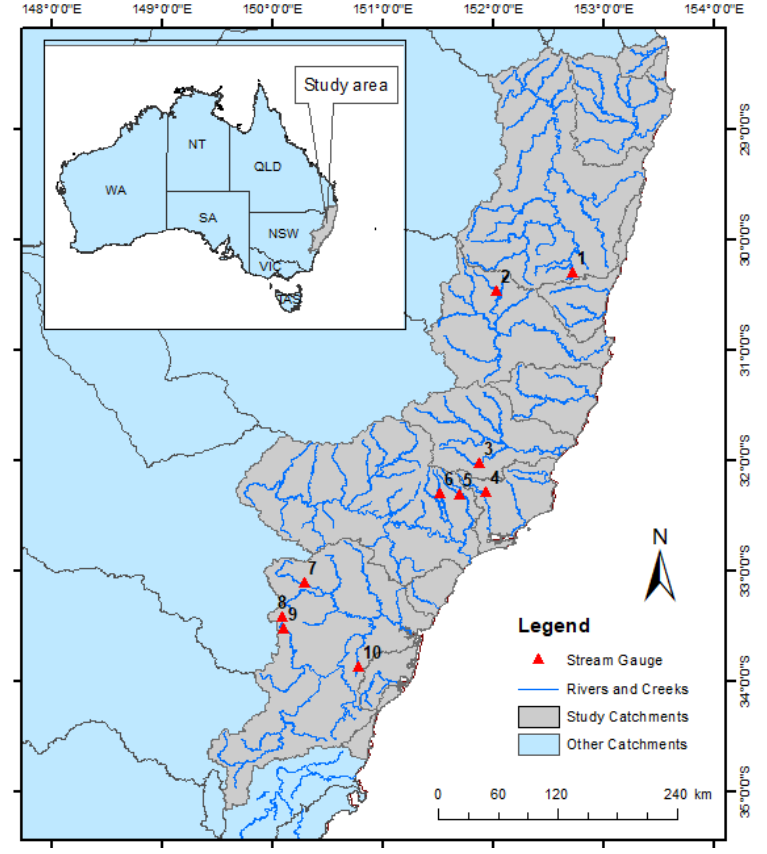
Figure 1. Study area map showing the location of catchments used for flood frequency and uncertainty estimates. Table 1. Physical properties and data length for the selected stream-gauging stations * CV stands for co- efficient of variation. Station Station No. ID